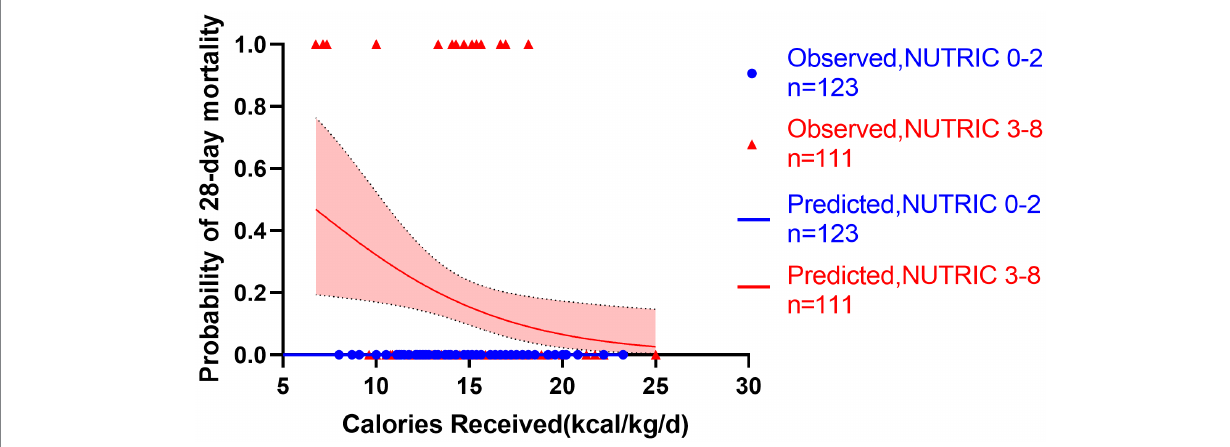
FIGURE 7 Predicted probability of 28-day mortality versus calories received by low NUTRIC 0-2 (blue line, n = 123) versus high NUTRIC 3-8 (red line, n = 111). Blue cycles represent the low NUTRIC score cases while red triangles represent the high NUTRIC score cases. Test for interactions were assessed by a logistic model including the NUTRIC score, the energy provision and their product (interaction). The test for interaction confirmed the association between energy provision and mortality is significantly modified by the NUTRIC score (test for interaction p < 0.001).